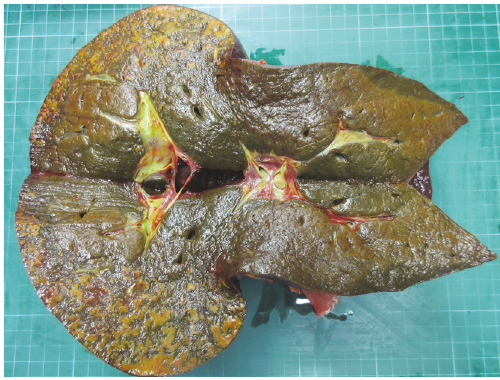
Figure 7: Transection of the resected native liver (1850